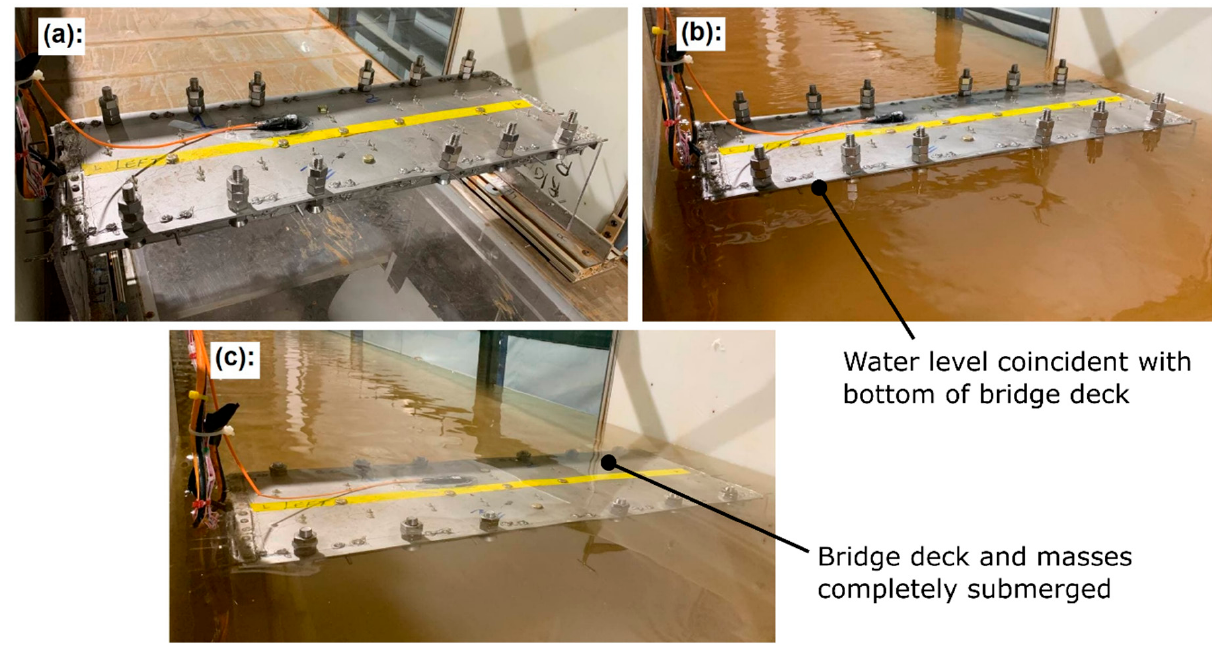
Figure 8. Experimental setup of the small-scale bridge in the flume laboratory in progressive flood stages: ( a ) dry; ( b ) semi-inundated; ( c ) fully inundated. stages: ( a ) dry; ( b ) semi-inundated; ( c ) fully